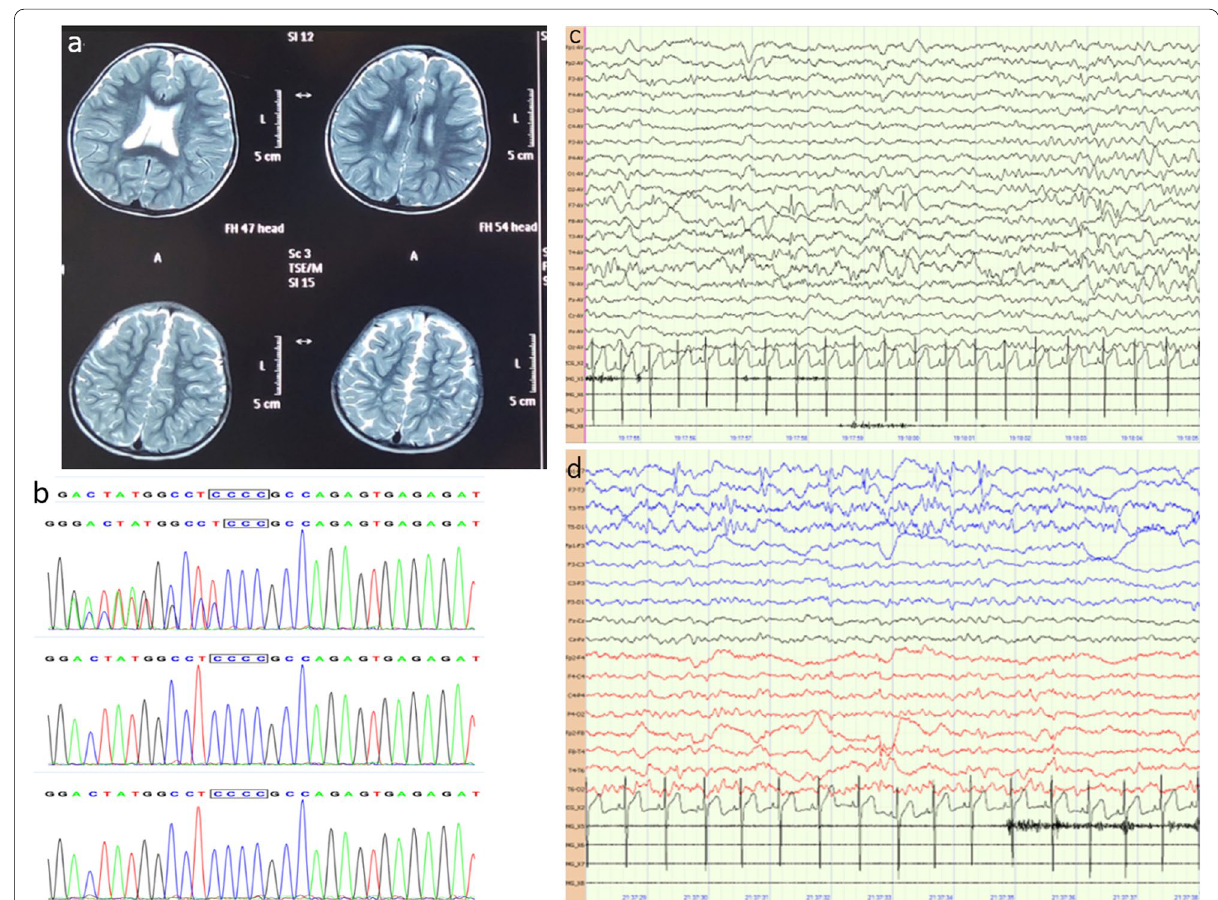
Fig. 4 a Brain MRI. Cranial magnetic resonance T2-weighted images showed widening of the septum pellucidum with formation of the fifth and sixth ventricles, a slightly wider median cleft of the brain, and bifrontal gyral atrophy. b Sanger sequencing verified the de novo GRIN2B c.870(exon3) del, as the parents were wild type at this site. c , d Scalp EEG. Interictal single or continuous spike slow waves were recorded at F7 and T5 both on average lead ( c ) and bipolar ( d